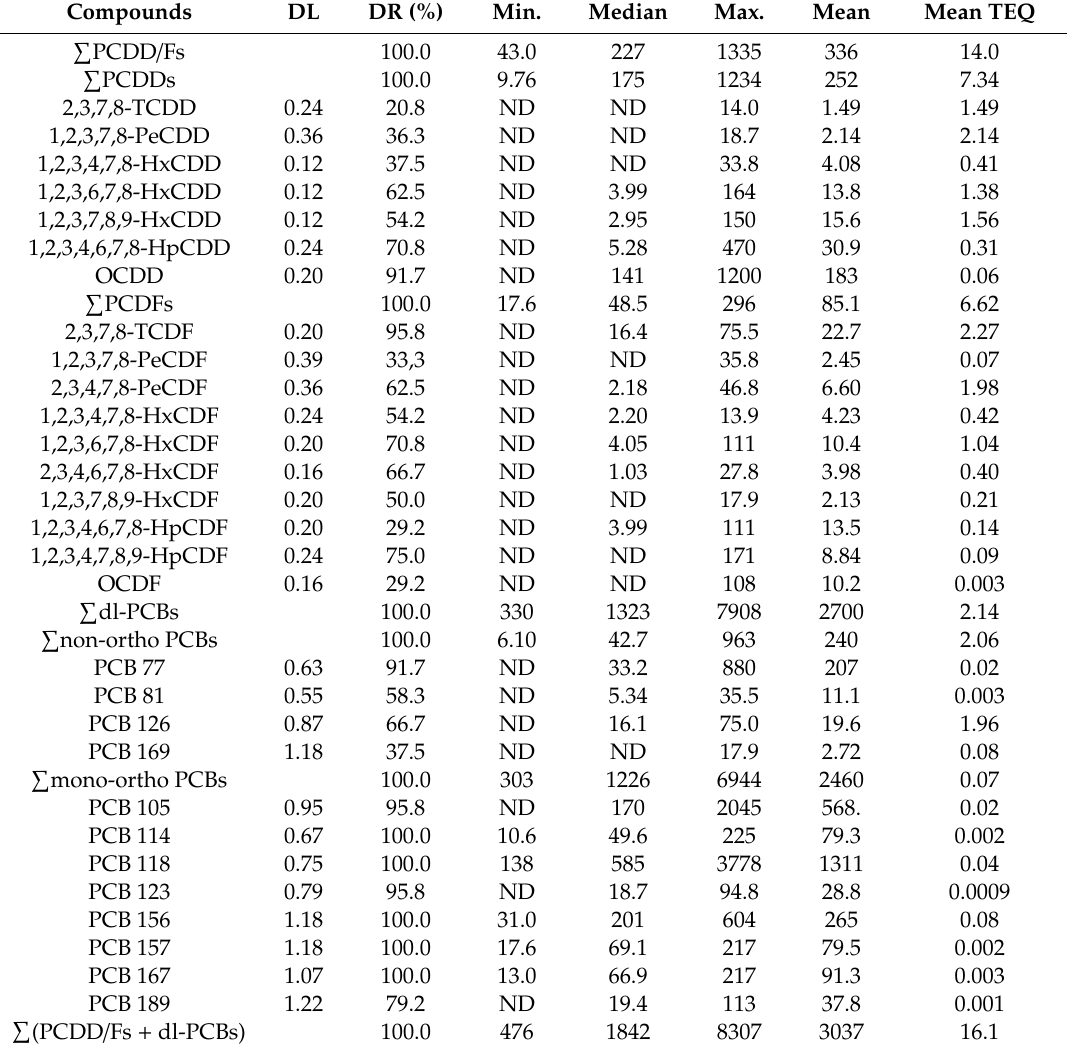
Table 1. Descriptive statistics of PCDD / Fs and dl-PCBs congers in cord serum samples, expressed as pg · g − 1 lipid ( n = 24). Compounds DL DR (%) Min. Median Max. (cid:80) PCDD /